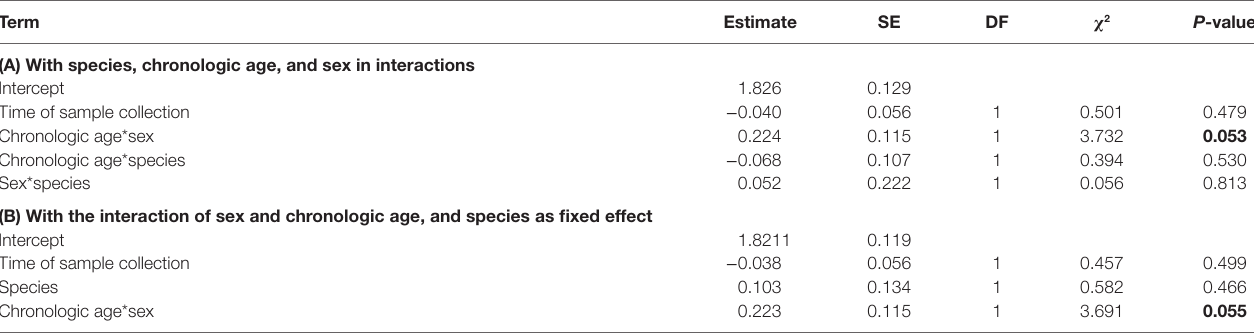
TaBle 1 | results of the two reduced general linear mixed models obtained by analyzing urinary igFBP-3 levels from chimpanzees and bonobos of both sexes: (a) with species, chronologic age, and sex in interactions; and (B) with the interaction of sex and chronologic age, and species as fixed effect. Term estimate se DF χ 2 P